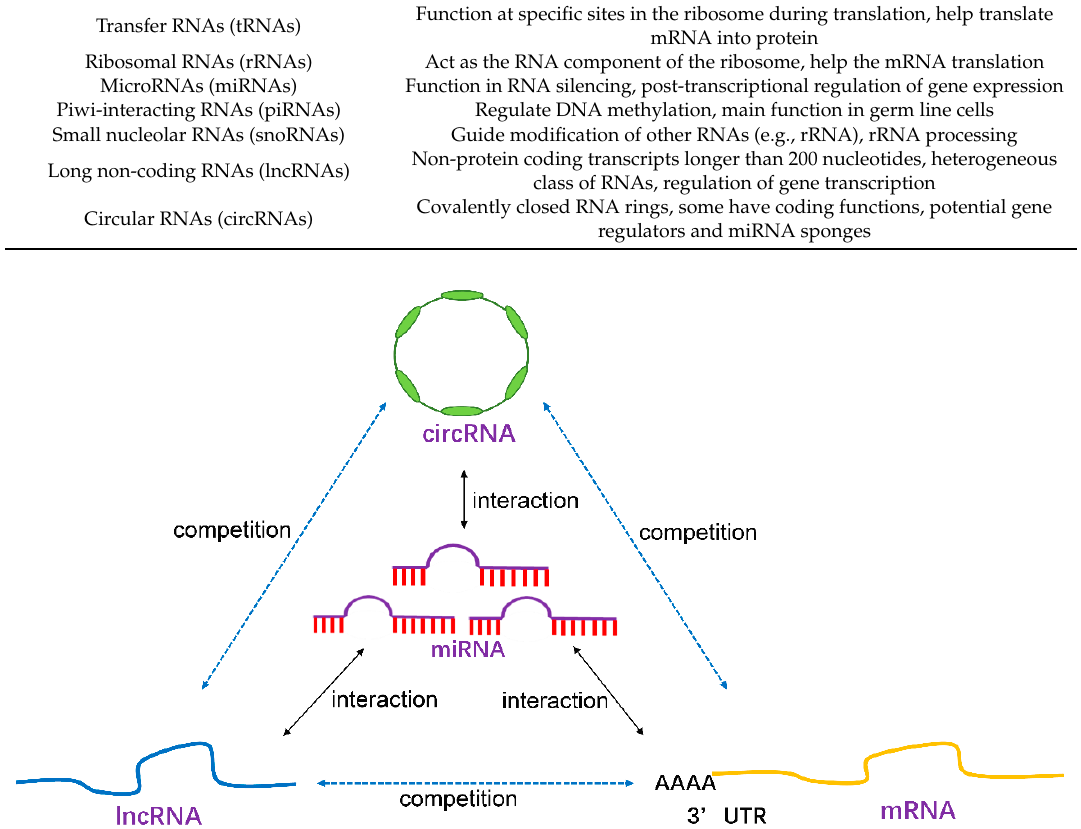
Figure 1. Interaction of di ff erent types of ncRNAs (miRNA, lncRNA, and circRNA).